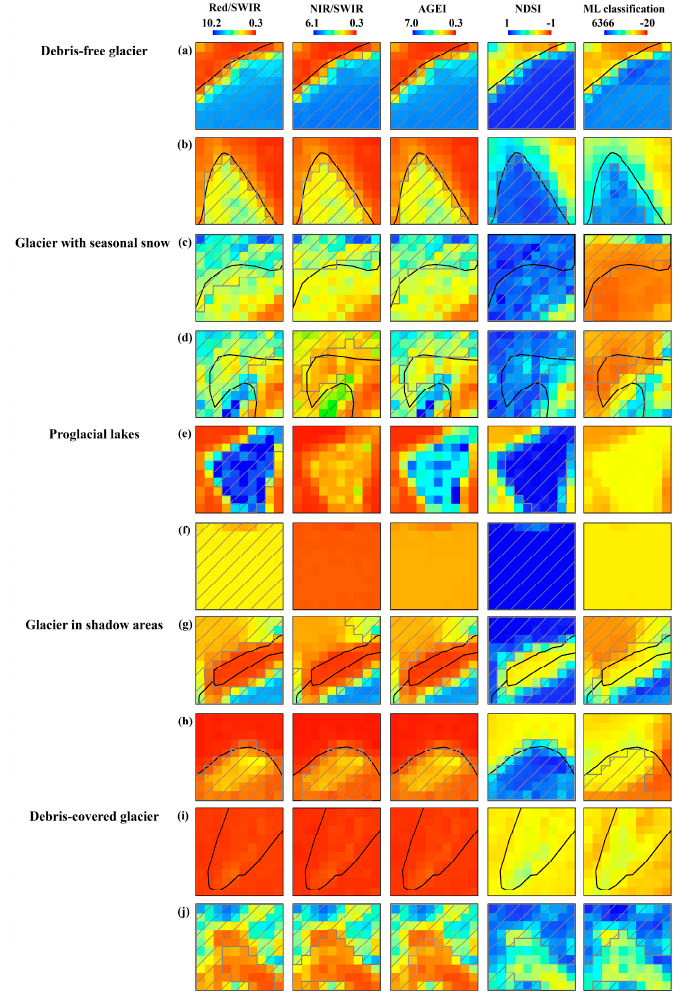
Figure 8. Five methods for the ten validation plots, including manual digitized Google Earth reference glacier boundaries (black outlines) and classified glaciers (grey hatched lines). Five challenging features were selected to compare performances of the five methods: ( a , b ) debris-free glaciers; ( c , d ) glaciers with seasonal snow; ( e , f ) proglacial lakes; ( g , h ) glaciers in shadowed areas; ( i , j ) debris-covered glaciers.